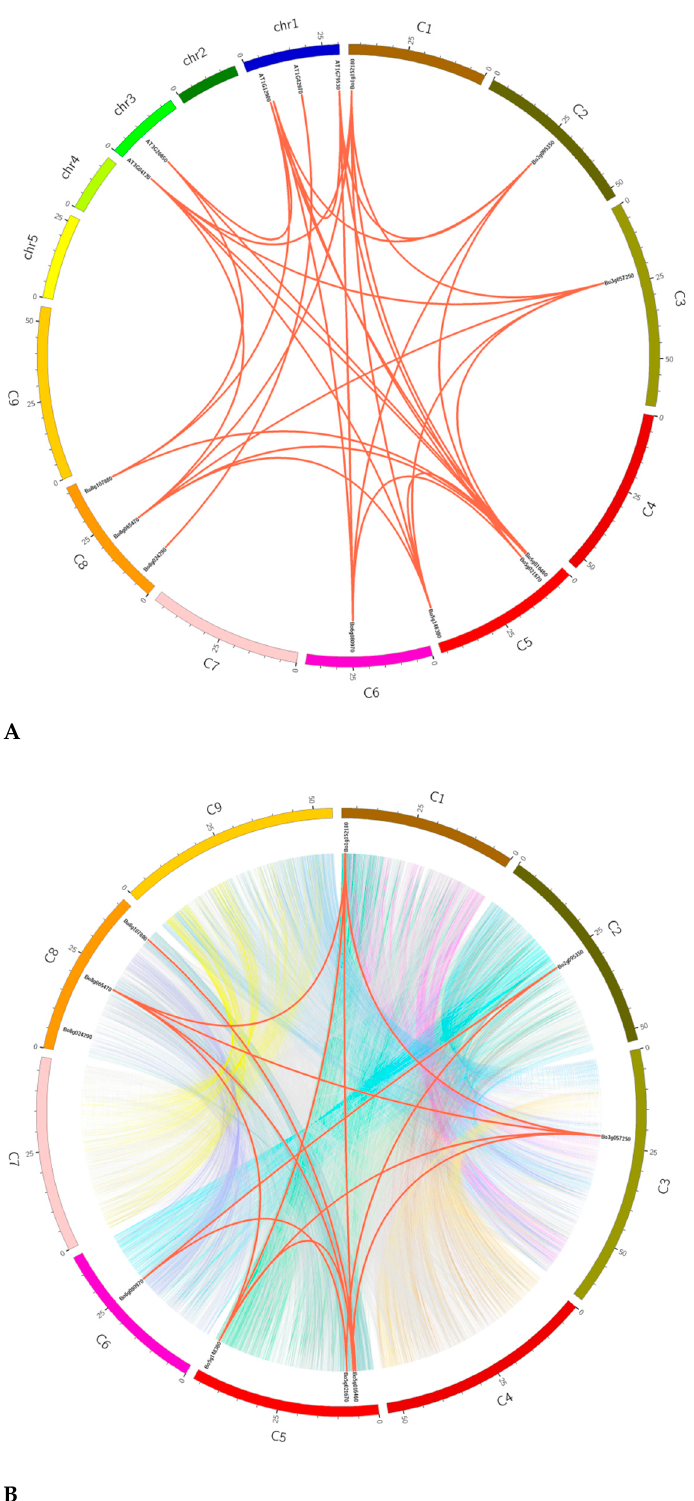
Figure 5. GAPDH gene tandem replication in the B. oleracea genome and between the B. oleracea and Arabidopsis genomes. ( A ) GAPDH gene tandem replication event between B. oleracea C1–C9 and Arabidopsis Chr1–Chr5. The solid red line indicates tandem duplication between genes. ( B ) Tandem replication events between the B. oleracea C1–C9 chromosomes. The solid red line indicates the replication between GAPDH genes, and the blocks with different colors in the background indicate the replication of all genes in the B. oleracea genome.